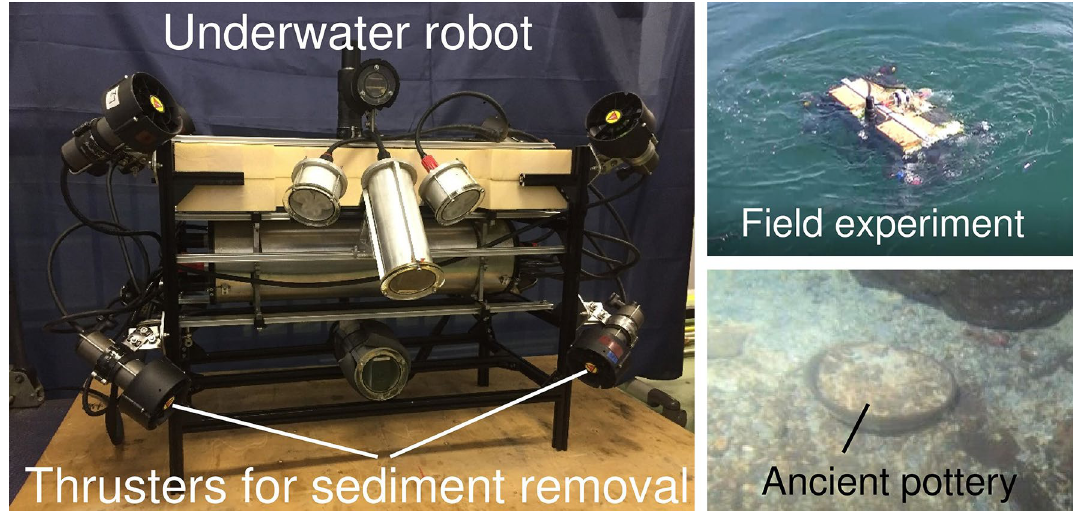
Fig. 1 The developed underwater robot and ancient pottery discovered by this robot during non-destructive survey. The pottery was covered with some